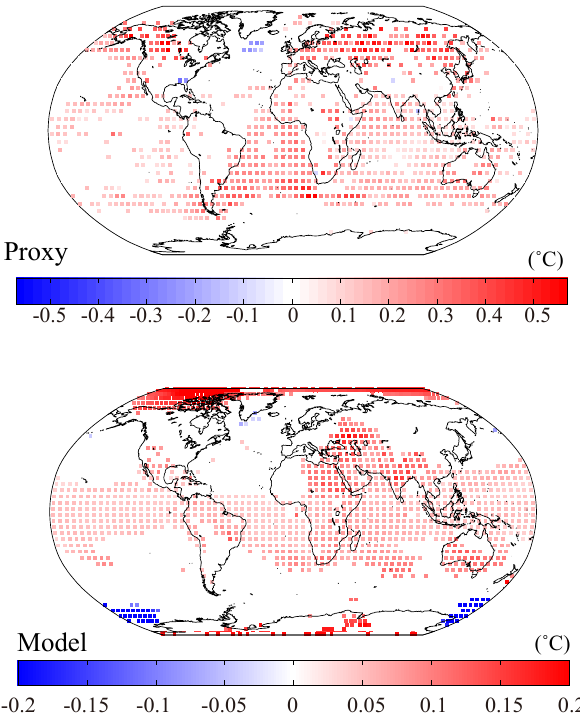
Fig. 8. Composite annual mean temperature differences (stronger solar output – weaker solar output) as defined in Fig. 3 from the model output (GISS-ER) and the proxy data (Mann et al., 2009). Only grids with 95% significance levels, calculated by re-sampling with two-sided tests as we do not have a priori knowledge on warmer or cooler responses to solar variations except in Greenland, are shown in color. For the GISS-ER (ensemble mean result), the solar forcing from the Maunder Minimum to the late 20th century is 0.38Wm − 2 .